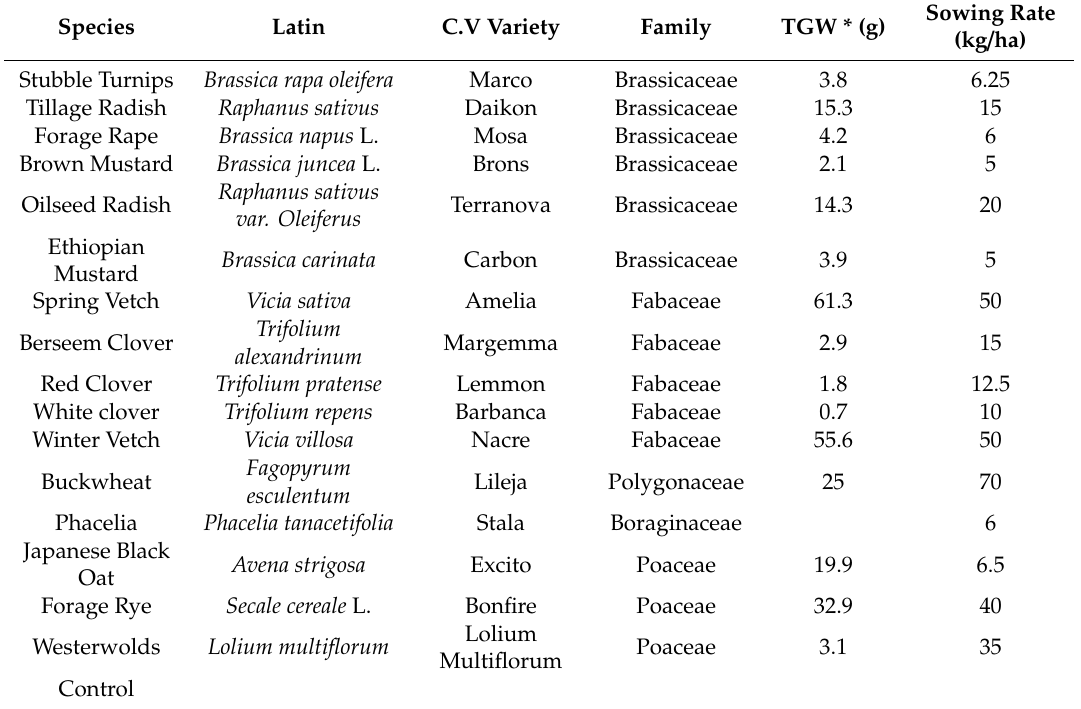
Table A1. Species— Varieties.